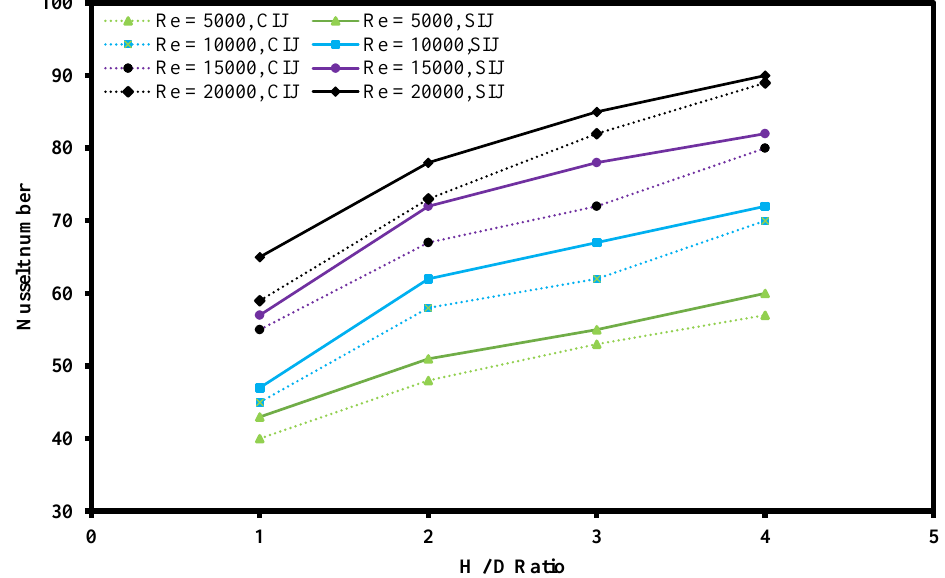
Figure 18. Effect of H/D ratio on Nusselt number for SIJ and CIJ.